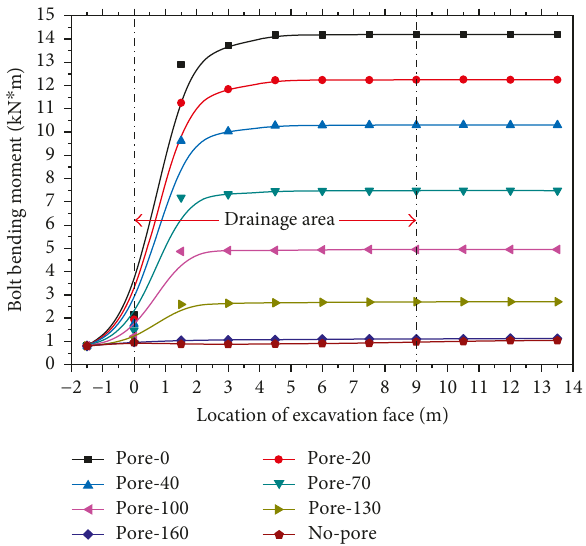
Figure 22: The maximum moment of bolt.